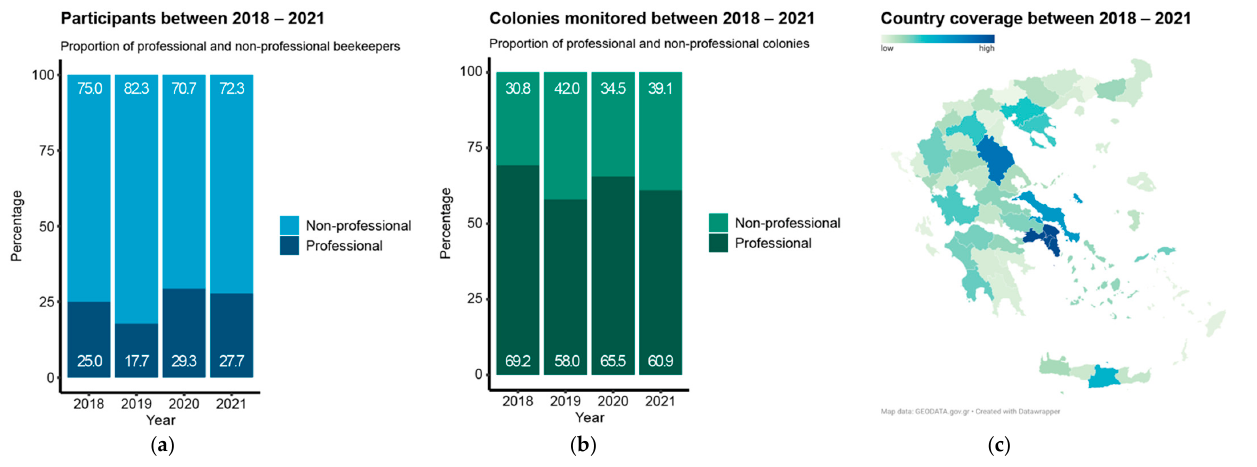
Figure 1. Constant distribution of the types of participants and monitored colonies across the years all over Greece: ( a ) stack bar plots showing the proportion of participants and; ( b ) monitored colonies in relation to their socio-professional situation (professional beekeepers > 150 hives); ( c ) map coverage of total participation across four